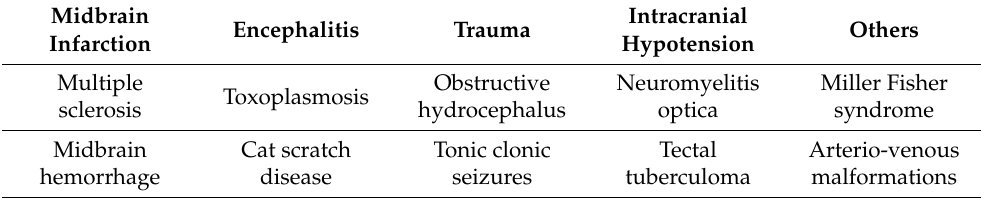
Table 3. Etiologies of Parinaud’s